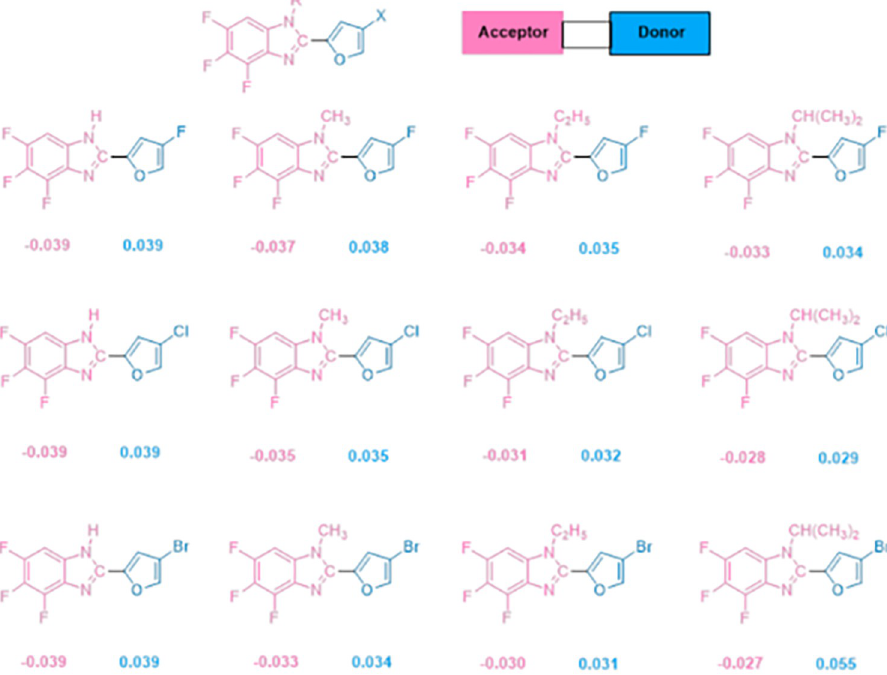
Fig 16. NBO charges we calculated at the B3LYP/6-311+G(d,p) level illustrate donor-acceptor interaction in fuberidazole derivatives 5a-5p.